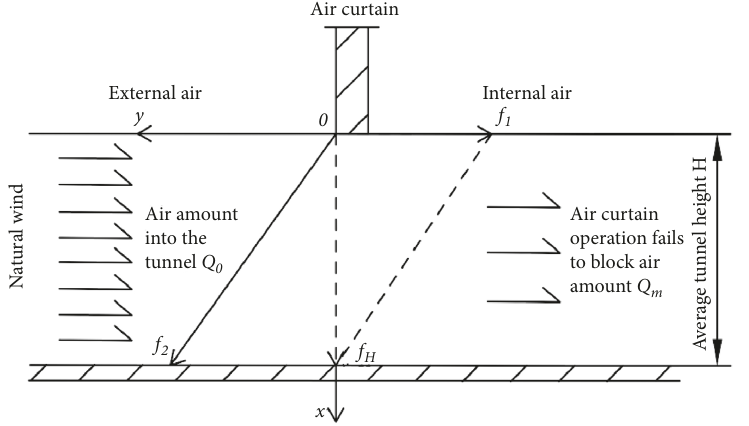
Figure 5: Air amount calculation